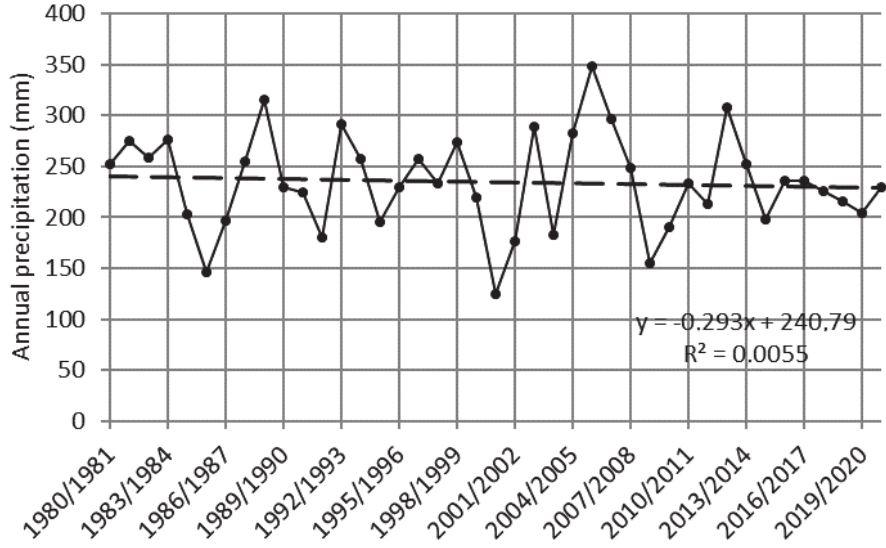
Figure 3. Long ‐ term variation in the annual precipitation (mm) at Yakutsk, 1981–2020. The dashed line indicates a linear trend.